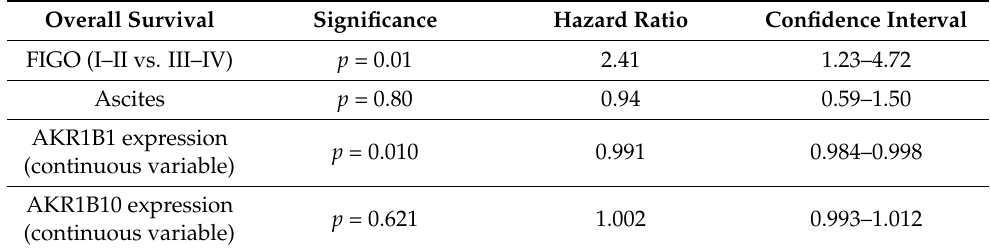
Figure 6. Overall and disease-free survival of patients with HGSC in relation to AKR1B1. ( a ) Overall survival ( p = 0.006) and ( b ) disease-free survival curves ( p = 0.002). The X-axis represents the percentages of AKR1B1-positive cancer cells. The Y-axis represents the hazard ratio for death ( a ) and disease relapse ( b ). AKR1B1: aldo-keto reductase family 1 member B1; HGSC: high-grade serous ovarian cancer. Table 3. Multivariate Cox analysis of independent prognostic factors of overall survival.